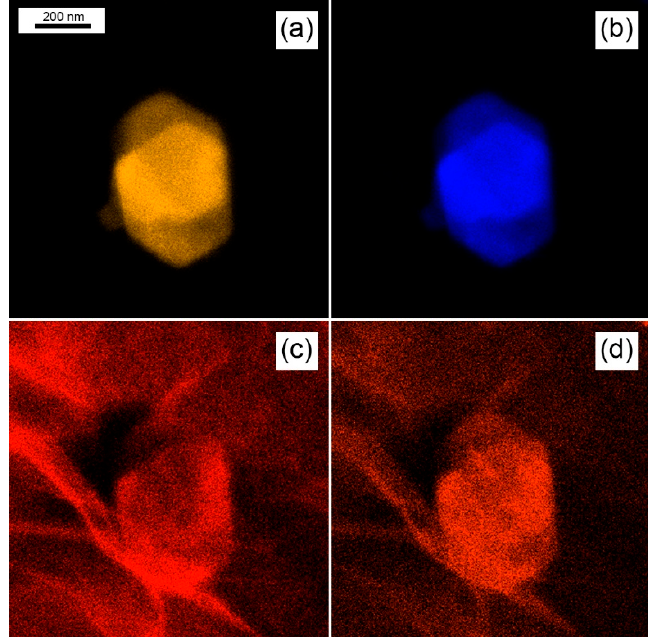
Figure 3. STEM elemental mapping of the flake shown in Figure 2b showing the atomic distribution of: ( a ) sulfur, ( b ) tungsten, ( c ) carbon and ( d ) oxygen.